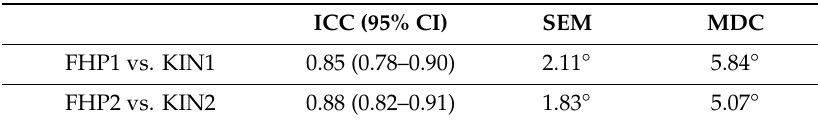
Table 3. FHPapp criterion validity.